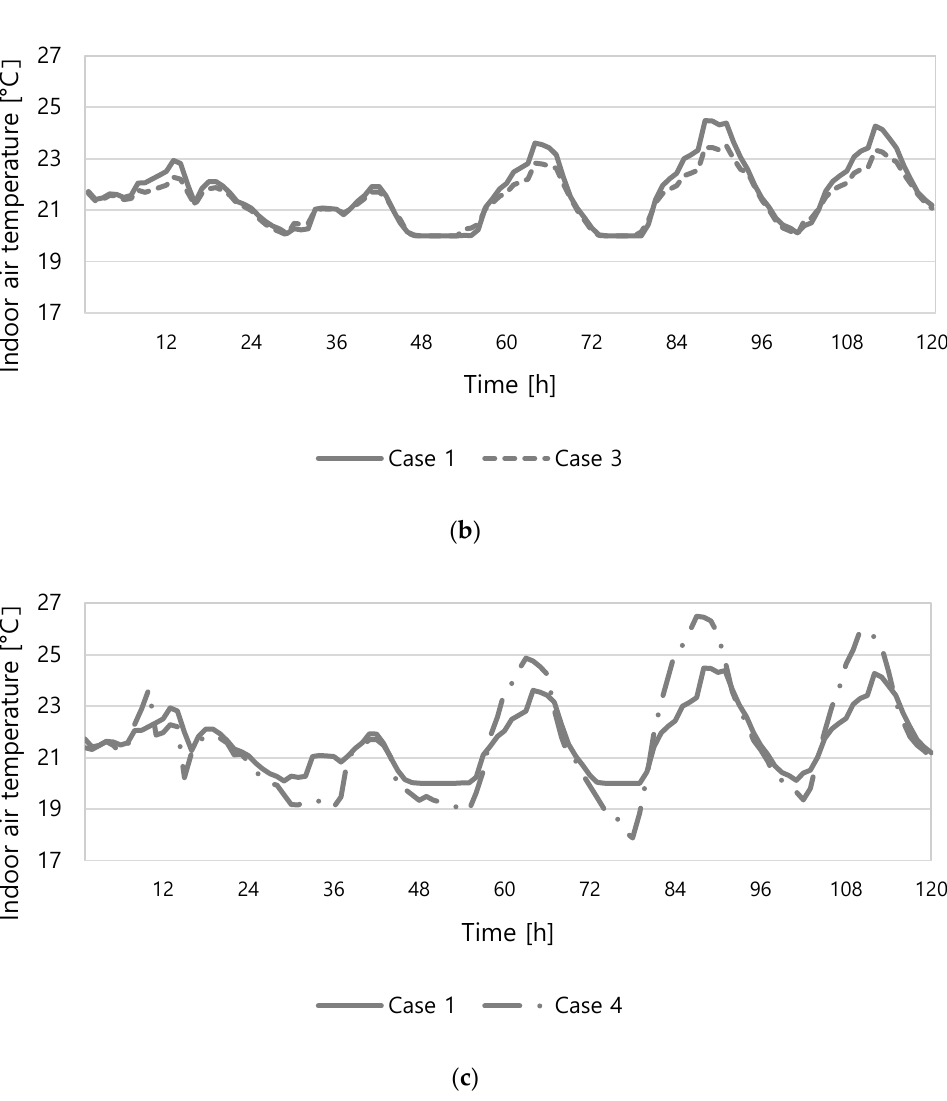
Figure 10. ( a ) The room air temperature comparison in a sample week of Case 1 with Case 2 (Bedroom 01). ( b ) The room air temperature comparison in a sample week of Case 1 with Case 3 (Bedroom 01). ( c ) The room air temperature comparison in a sample week of Case 1 with Case 4 (Bedroom 01). occupants, were compared and analyzed. When the indoor air velocity is 0.2 m/s or